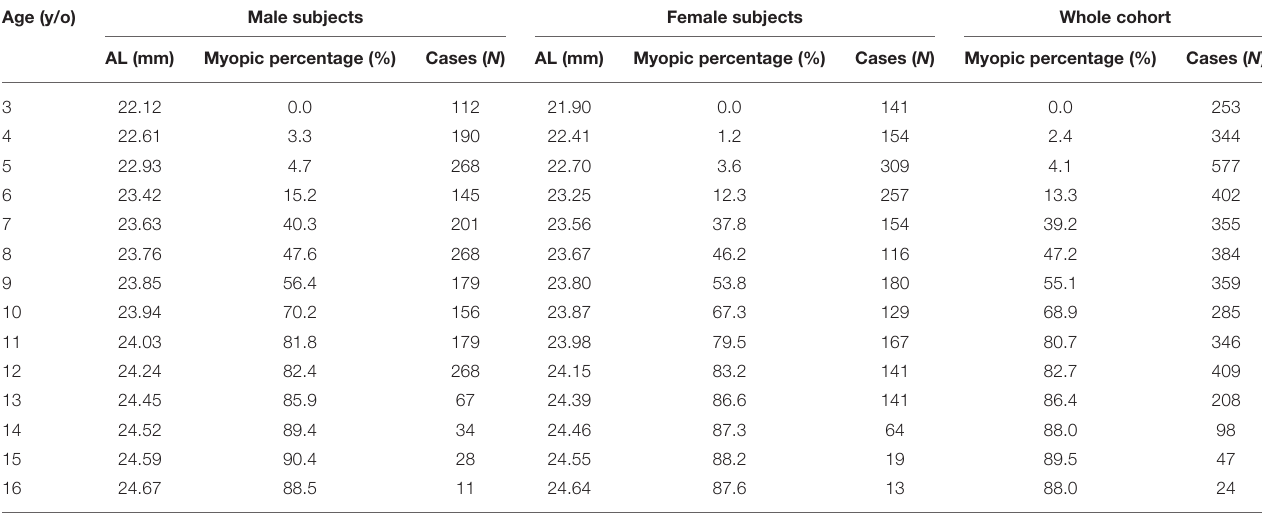
TABLE 1 | Demographic characteristics of children in the first part of the study. Age (y/o) Male subjects Female subjects Whole cohort Myopic percentage (%) Cases ( N ) AL (mm) Myopic percentage (%) Cases ( N ) Myopic percentage (%) Cases ( N )